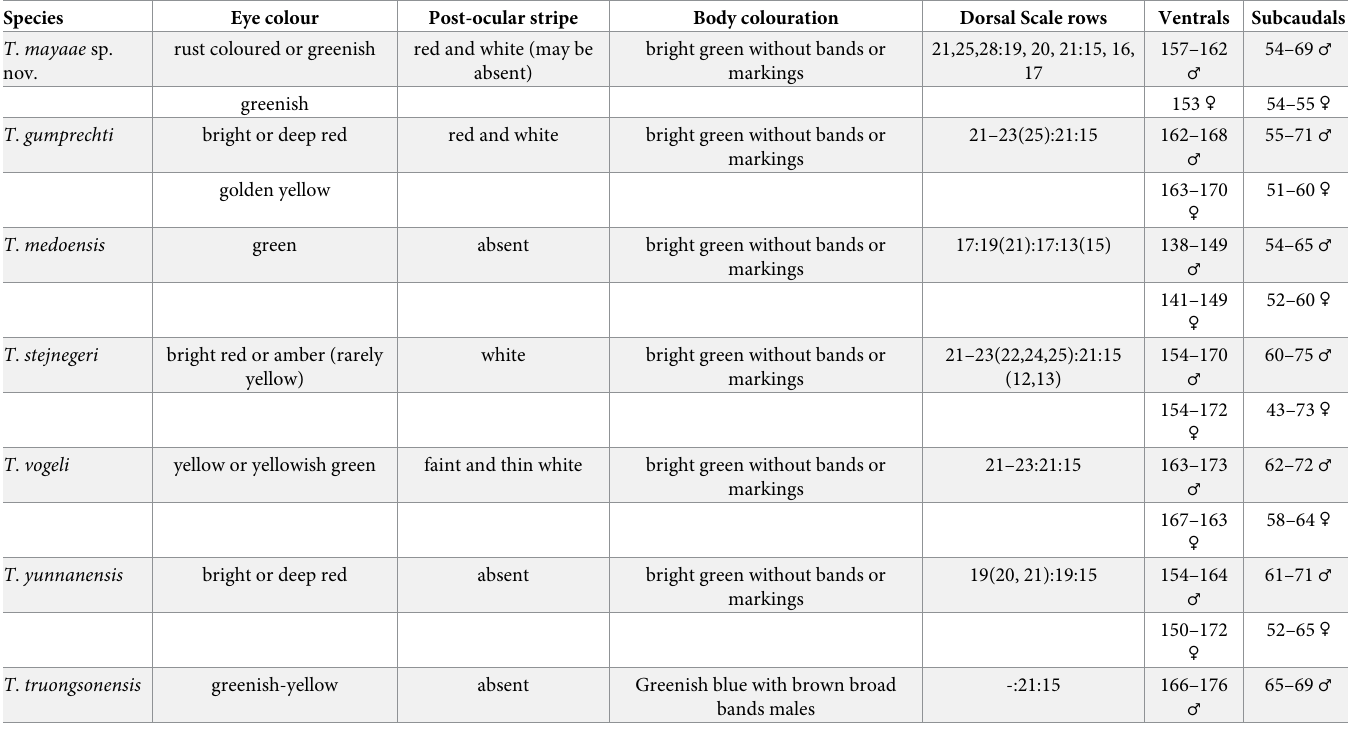
Table 2. A summary of characters of members of the subgenus Viridovipera . Data derived from Gumprecth et al.